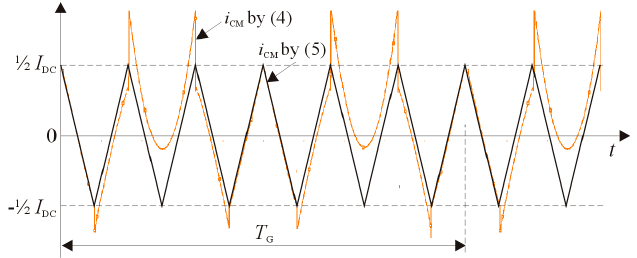
Figure 2. Shape of the current modulator (CM) current given by (4) and by (5).